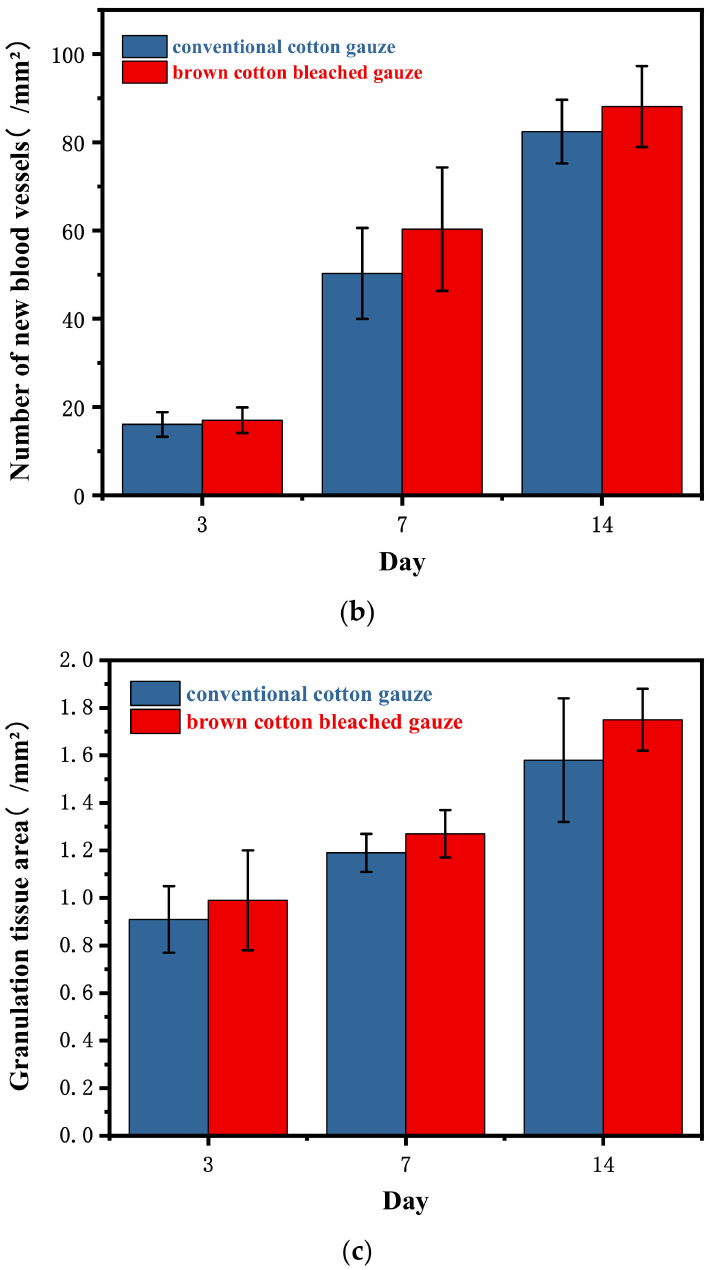
Figure 6. The number of inflammatory cells ( a ) and new blood vessels ( b ), and the area of granulation tissue ( c